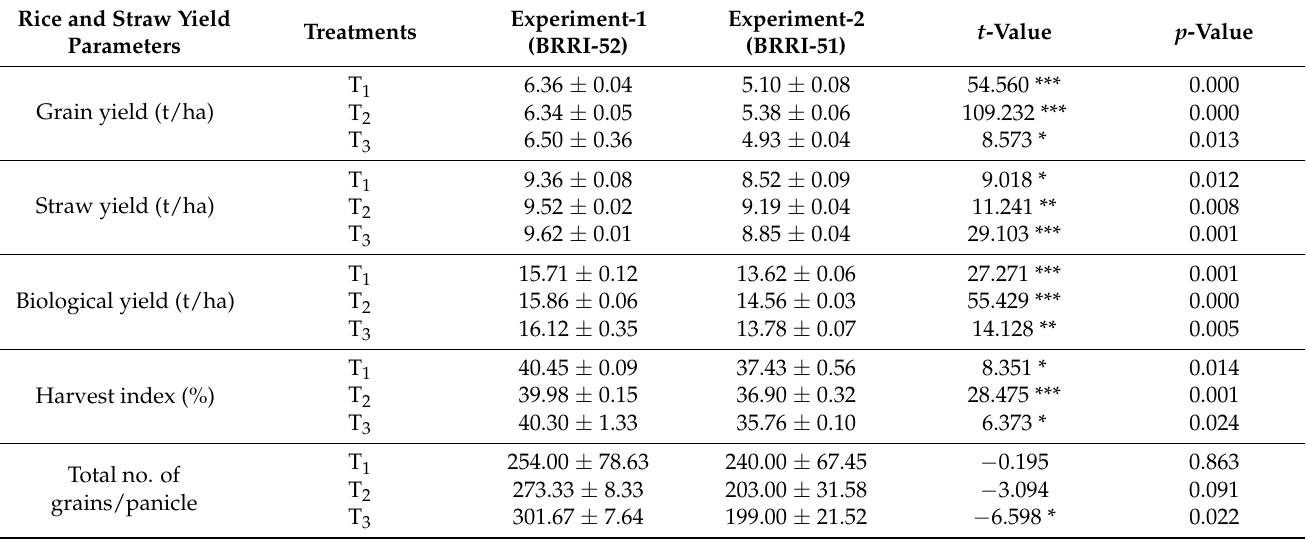
Table 3. Comparison of rice and straw yield parameters under different treatments in the rice–fish– vegetable culture